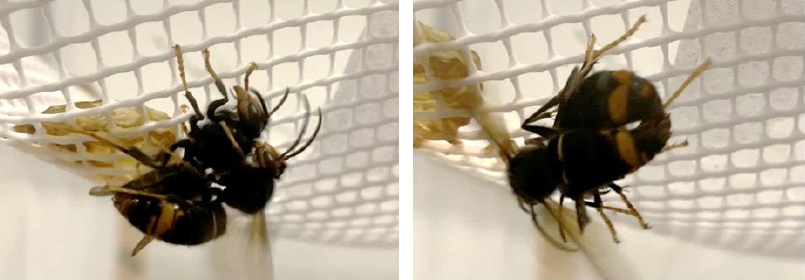
Figure 9. A couple of Vespa velutina from Nest 1 mating in captivity.